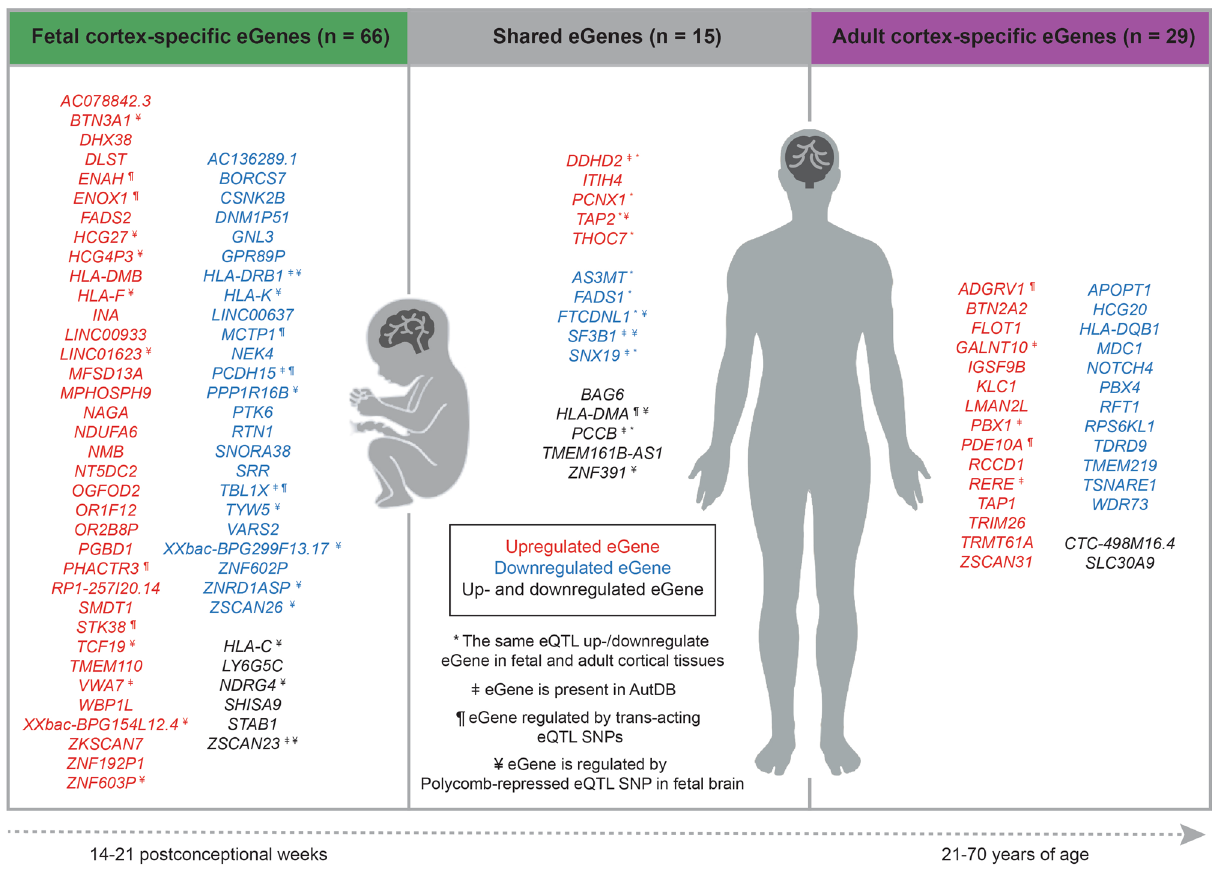
Figure 3. ASD-associated eQTLs mark loci that spatially regulate the expression of genes involved in the fetal brain, in the adult brain, or both. Transcript levels for 15 spatially regulated genes were altered by ASD- associated eQTLs in both the fetal and adult cortical tissues, 66 genes were specific to fetal cortex, and 29 eGenes were specific to the adult cortex. *The same eQTL is associated with transcription levels for the gene in both the fetal and adult cortical tissues. ǂ Genes that have been curated as being involved in ASD (AutDB 31 ; http:// autism.